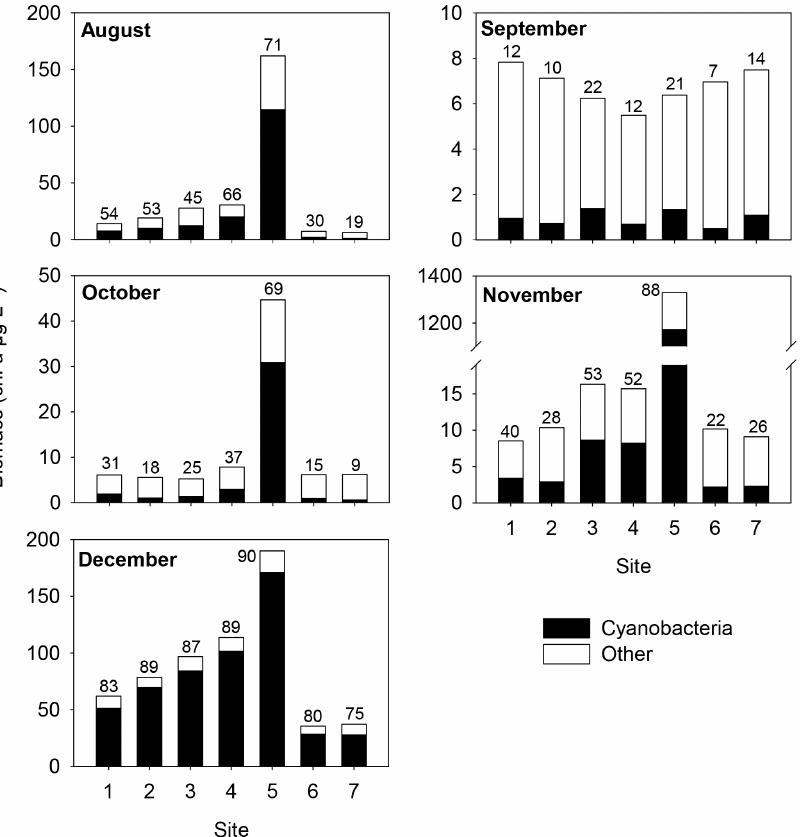
Figure 2. Biomass of cyanobacteria and other phytoplankton at each site in August to December 2010. Other phytoplankton is comprised of chlorophyta, diatoms, cryptophyta. Numbers represent cyanobacterial fraction, which is % of cyanobacteria of total phytoplankton. Please note that y-axes are at different scales. doi:10.1371/journal.pone.0066674.g002 PLOS ONE |